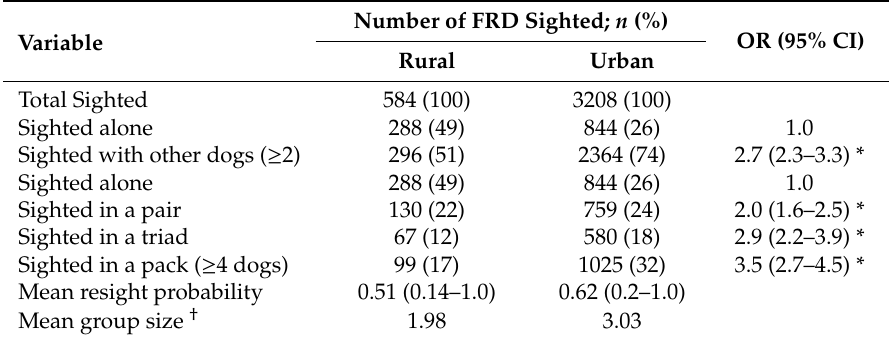
Table 1. The number and likelihood of free roaming dogs (FRD) being sighted alone or with other dogs during the photographic sight-resight survey carried out in Shirsuphal (rural) and selected sectors of Panchkula (urban),